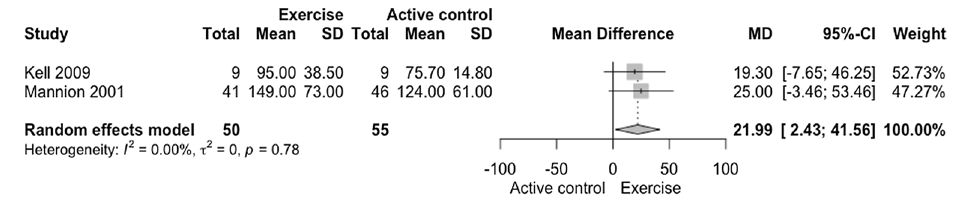
Figure 4. Forest plot of the comparison of exercise vs. active control on trunk extensor endurance. Mannion et al. (2001) 46 : Training Devices versus Multimodal Physical therapy; Sorensen test (seconds). Kell et al (2009) 51 : Resistance exercises versus Aerobic Training; Sorensen test (s).